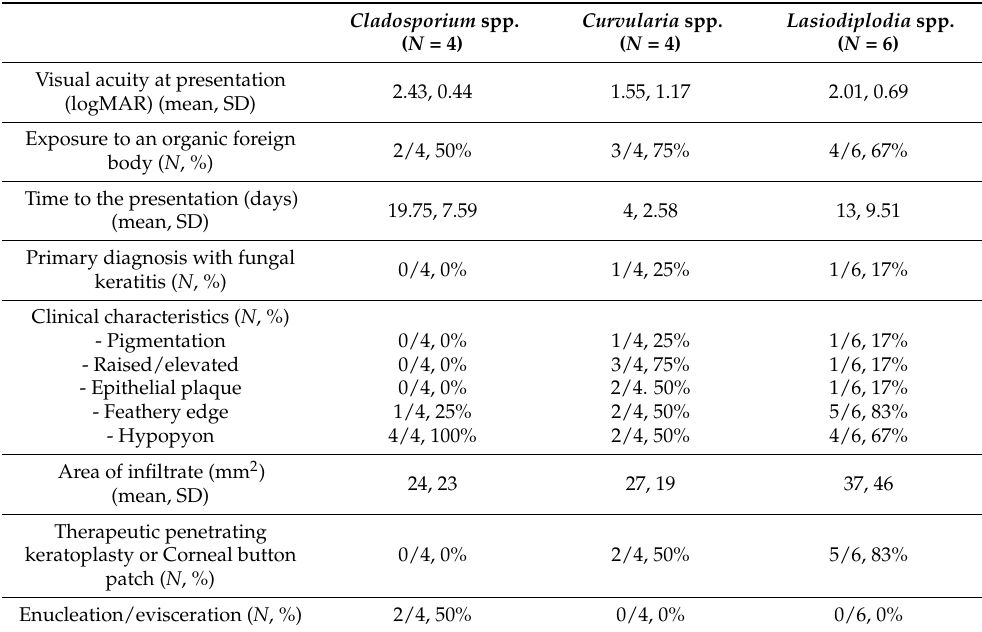
Table 7. Clinical characteristics of dematiaceous fungal keratitis caused by Cladosporium spp., Curvu- laria spp., and Lasiodiplodia